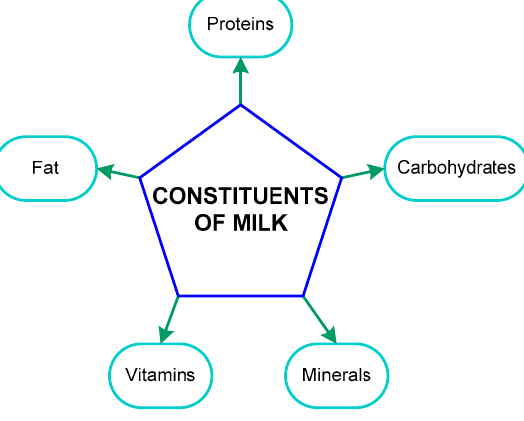
Figure 12. Constituents of milk.